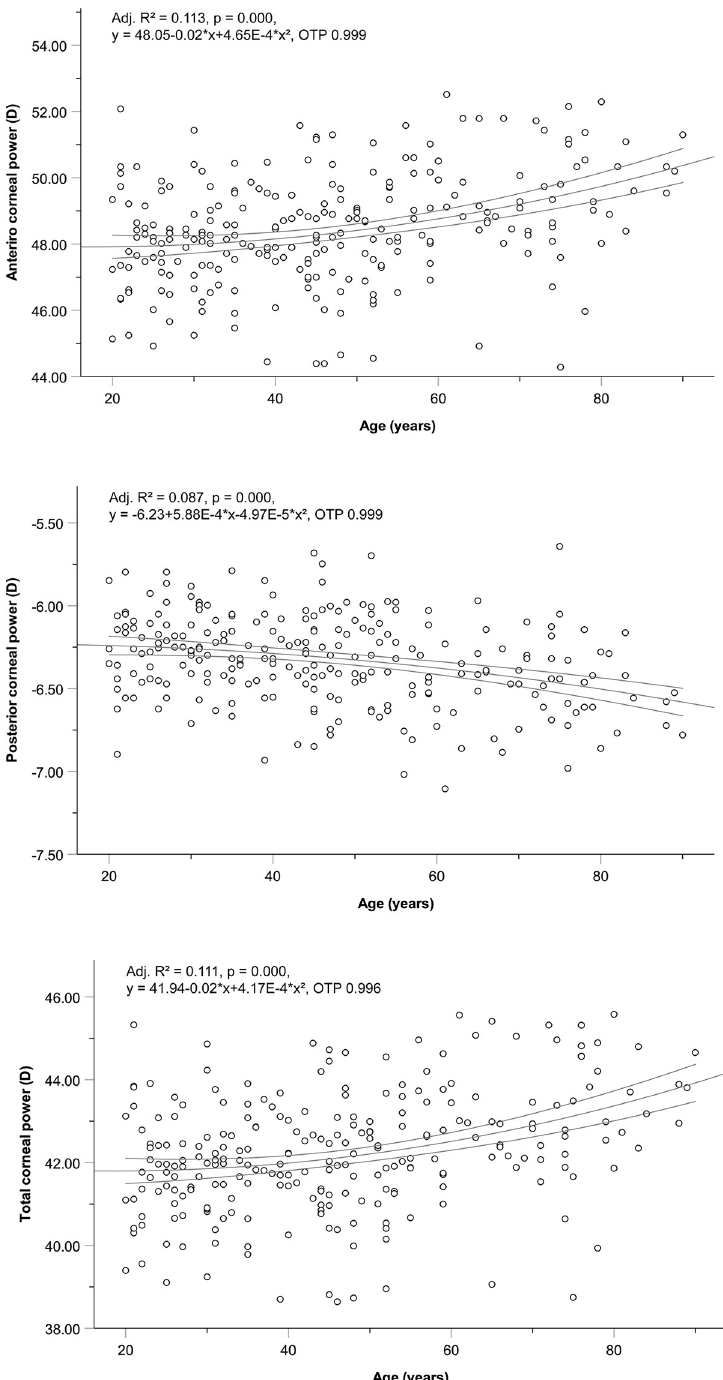
Fig 3. Age-associated changes in the corneal power. (a) Anterior corneal power (ACP); (b) Posterior corneal power (PCP); (c) Total corneal power (TCP). The three lines represent regression curves and 95% confidence intervals. D, diopter; Adj. R 2 , adjusted R 2 ; OTP, observation test